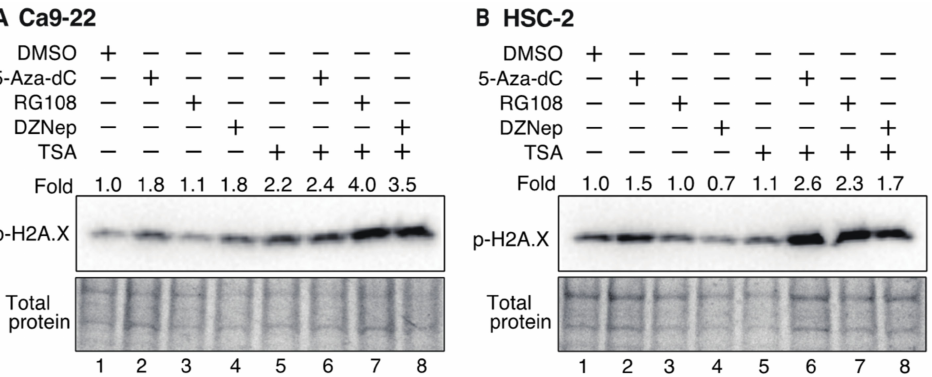
Figure 8. Phosphorylation of the histone variant H2A.X in Ca9-22 and HSC-2 cells treated with DNMTis, HMTis, and HDACis. p-H2A.X levels in Ca9-22 ( A ) or HSC-2 ( B ) following treatment with 5-Aza-dC (0.1 µ M), RG108 (5 µ M), DZNep (0.2 µ M), or TSA (0.05 µ M) alone or in combination for 72 h. p-H2A.X levels were normalized to the total loading protein. The fold expression of p-H2A.X relative to DMSO-treated samples is shown above each lane in the